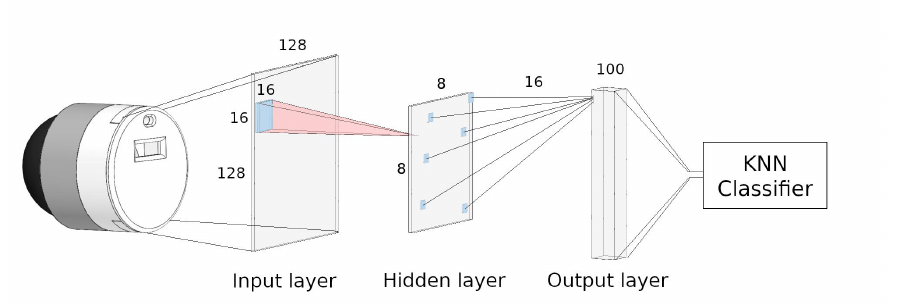
Figure 3. Architecture of the Spiking Neural Network. The input layer represents the captured data of the NeuroTac. Topographical pixel areas of 16 × 16 were used as inputs for the hidden layer. The output layer was then sampled again from 16 random neurons in the hidden layer. The output layer consisted of 100 neurons whose spike rate was fed into a K-nearest neighbour classifier. Note that the network structure presented here was obtained through optimisation, as described in Section